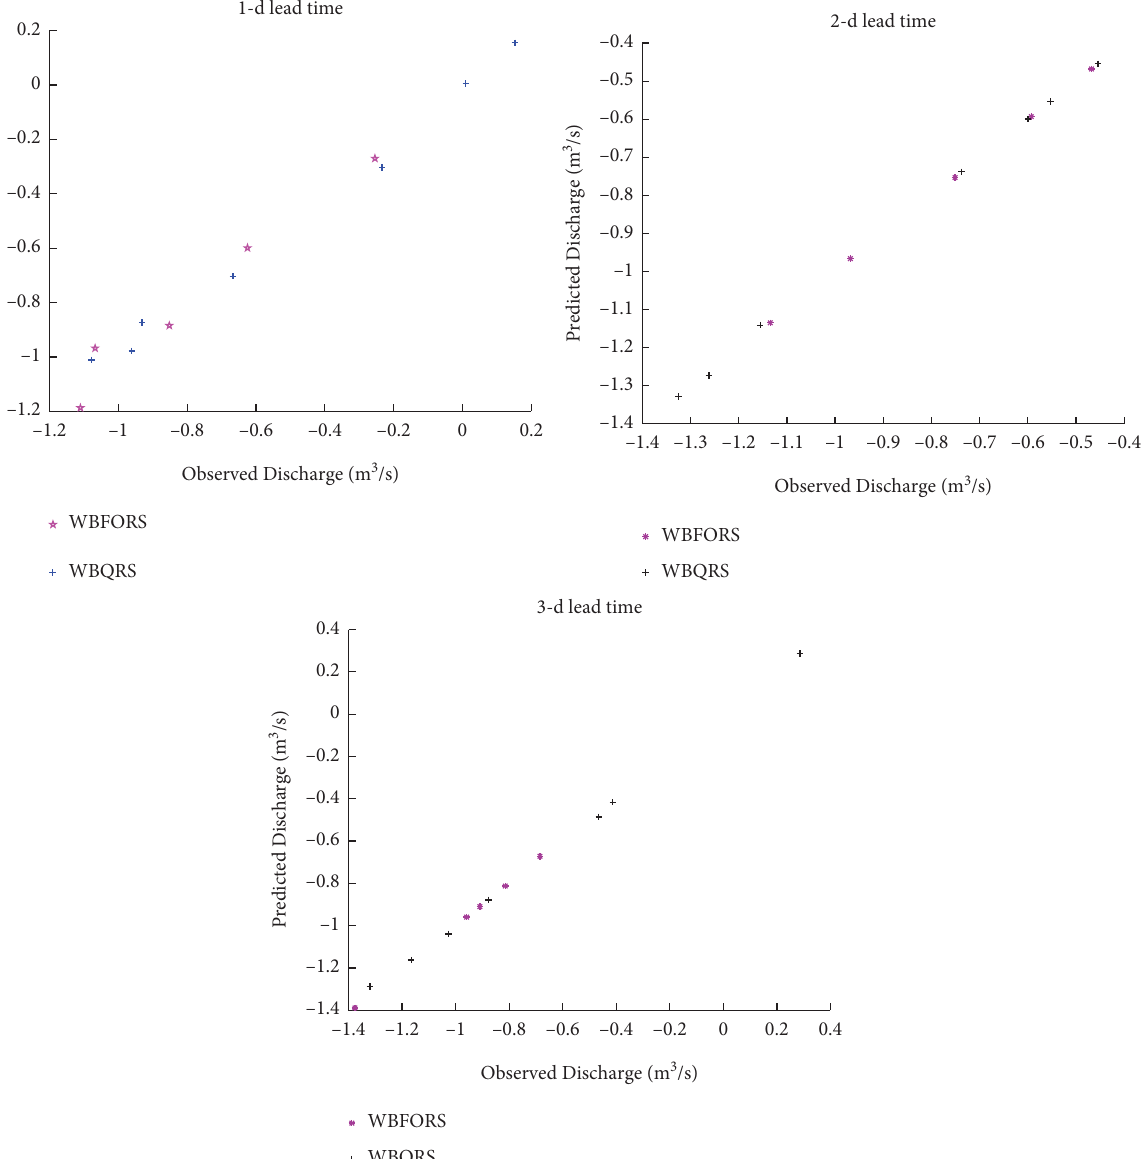
Figure 8: Represents scatter diagram of the observed reservoir fow against the predicted reservoir fow of WBFORS and WBQRS